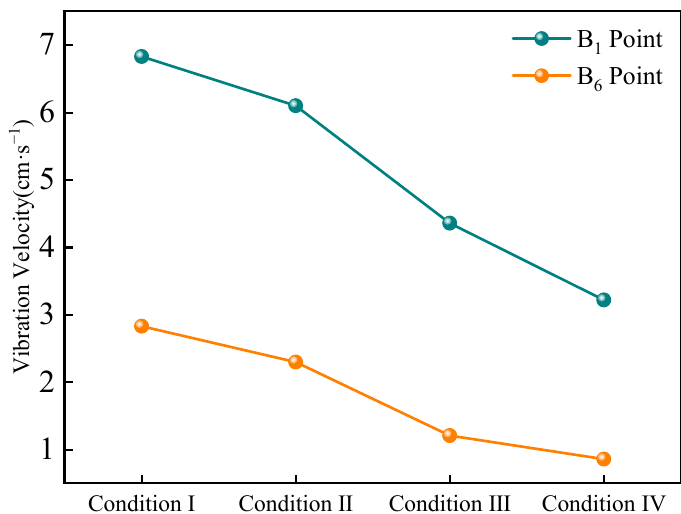
Figure 12. The peak vibration velocity of points B 1 –B 6 .